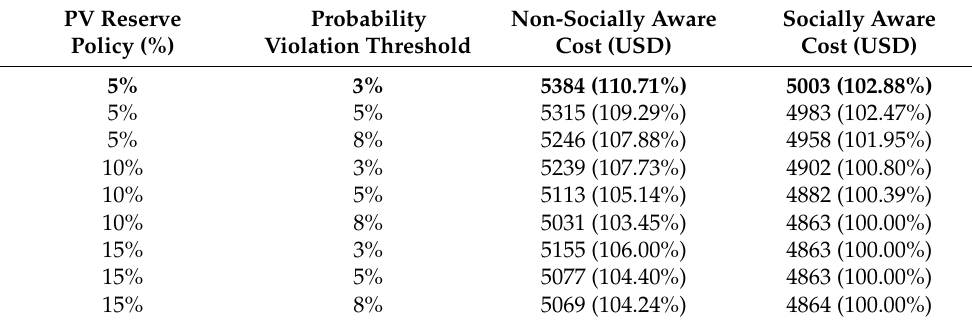
Table 4. Total System Operation Cost for Case II.